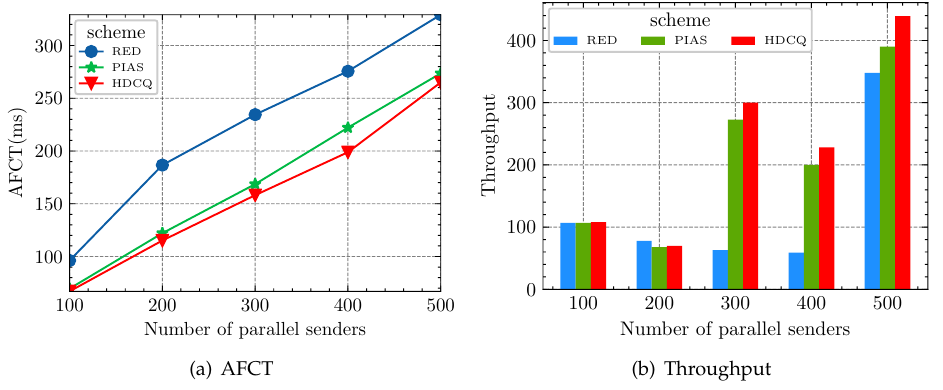
Figure 8. Incast environment: the impact of different scheme on short-flow AFCT and long-flow